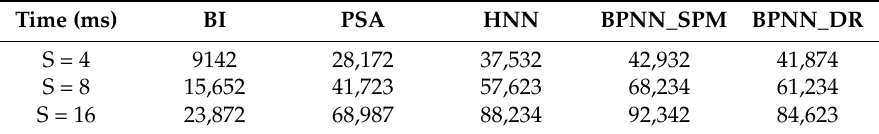
Table 3. Time costs of the five methods with 4, 8, and 16 scale factors for synthetic data.